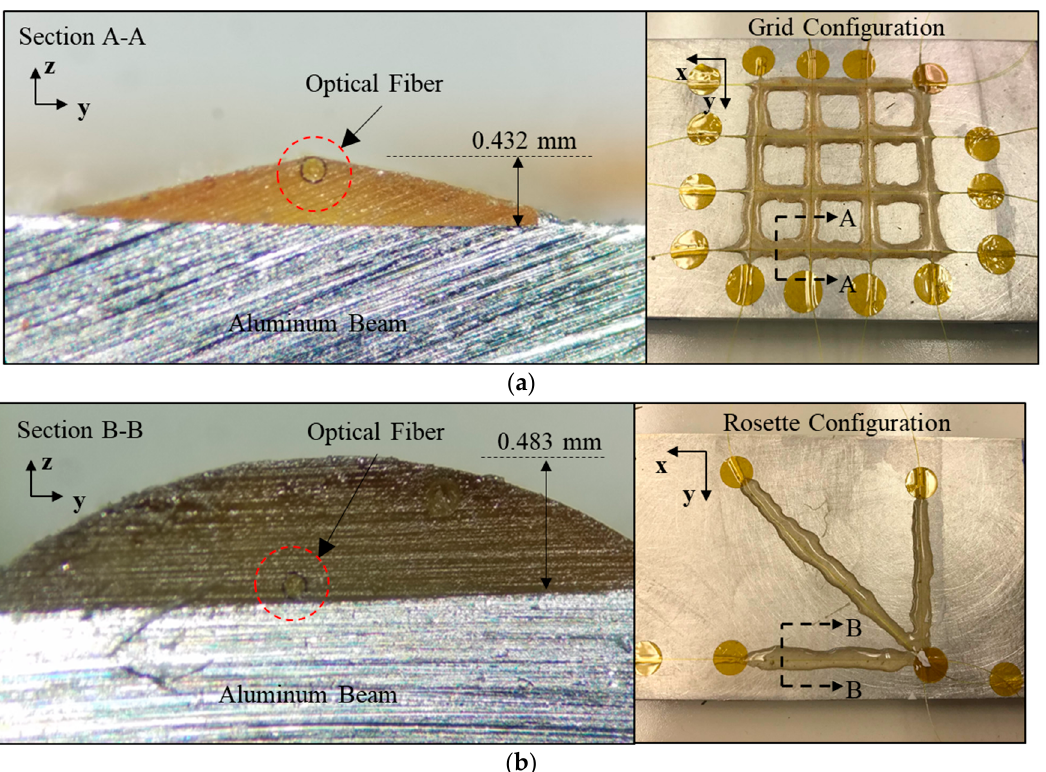
Figure 8. Cross-sectional images of aluminum beam showing placement of optical fiber in the ( a ) grid and ( b ) rosette configurations.